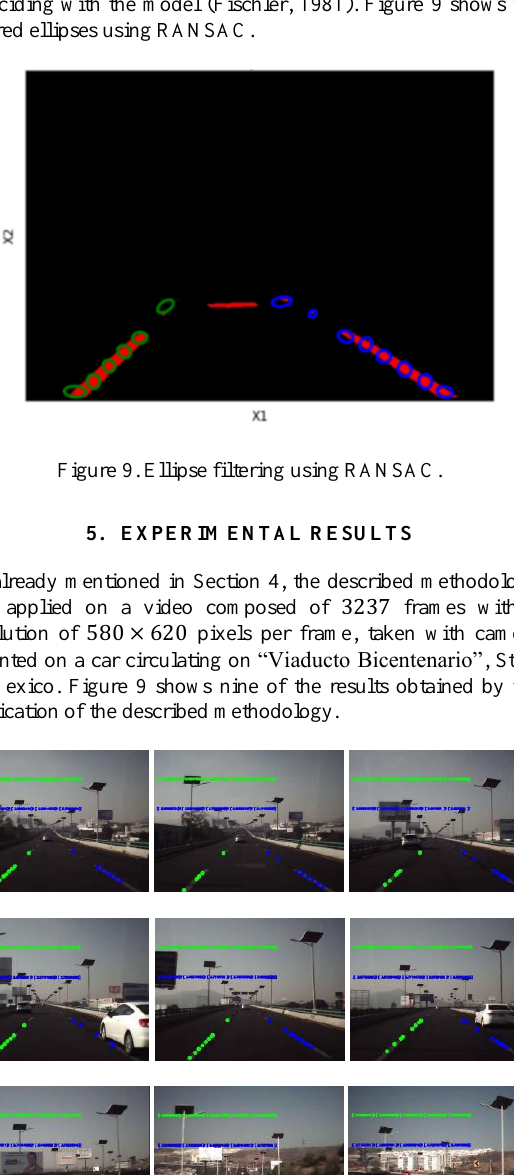
Figure 8. Establishment of the ellipses on the binary image by means of an ENNDP.